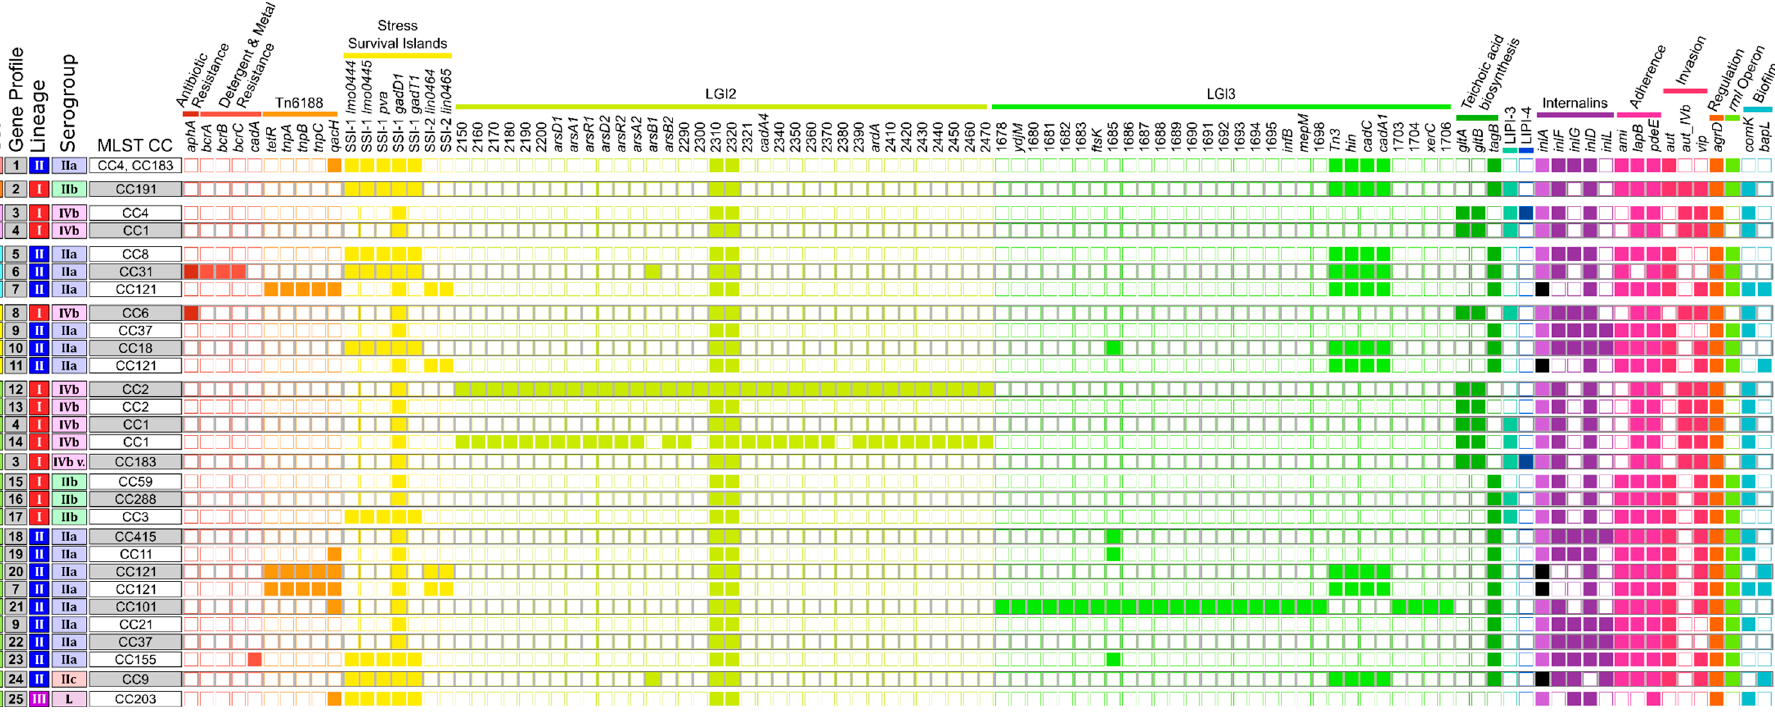
Figure 1. The 25 gene presence/absence profiles assigned to the 92 isolates according to the analyzed sets. The respective lineages, serogroups, and MLST CCs are also indicated. Full squares indicate detection, and empty squares no detection of the respective gene. Black squares depict inlA alleles with internal stop codons. Abbreviations: SSI, stress survival island; LGI, Listeria genomic island; LIPI, Listeria pathogenicity island.